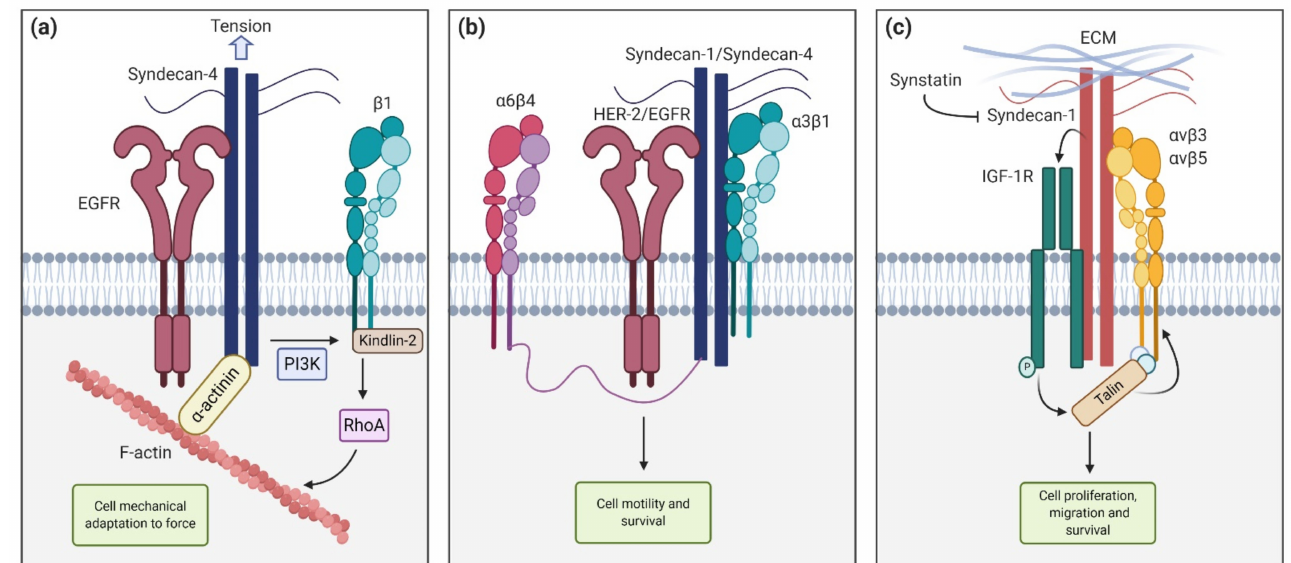
Figure 2. Syndecan functions and interactions. ( a ) Syndecan-4 cooperates with Epithelial Growth Factor Receptor (EGFR) and β 1-integrin to tune cell mechanics in response to tension ( b ) Syndecan-1 and syndecan-4 interact with HER-2 and EGFR respectively, and with α 6 β 4 and α 3 β 1 to promote cell motility and survival ( c ) Syndecan-1 interaction with insulin- like growth factor-1 receptor (IGF1-R) activates talin, which in turn activates α v β 3 and α v β 5 integrins, leading to cell proliferation, migration, and survival. These interactions can be blocked with the synstatin